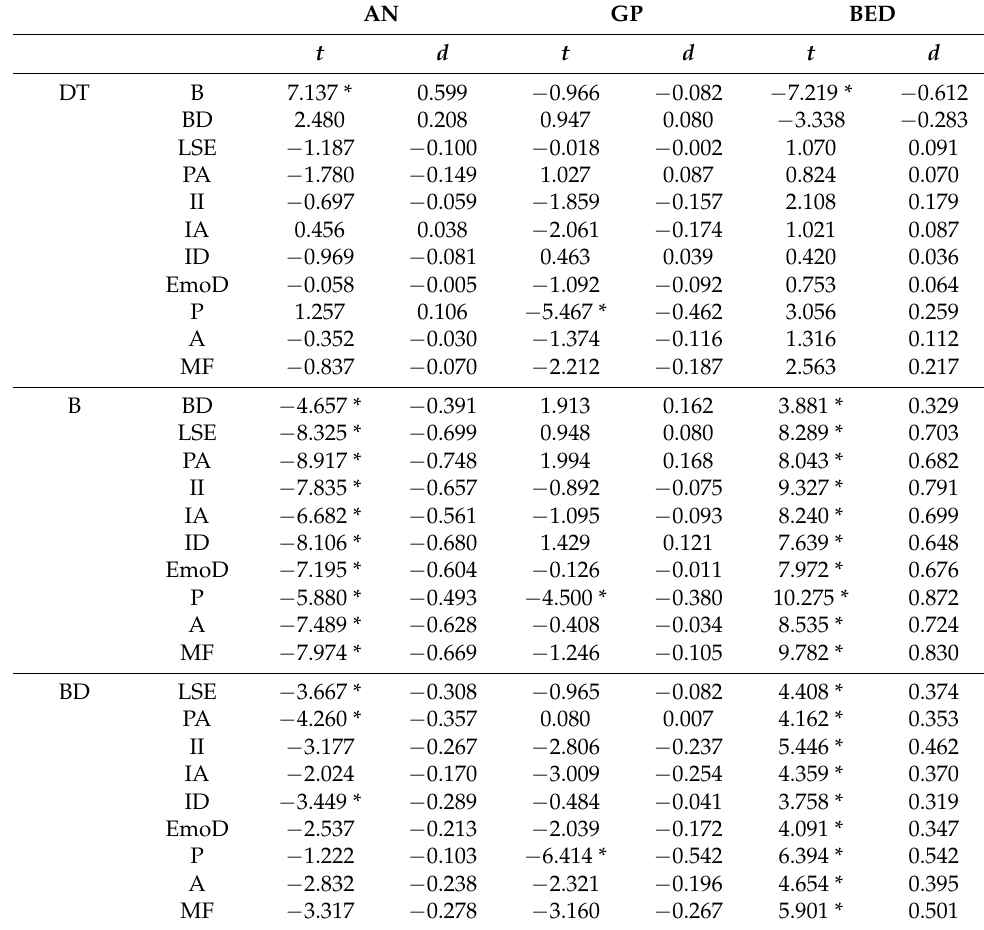
Table 3. Within-group